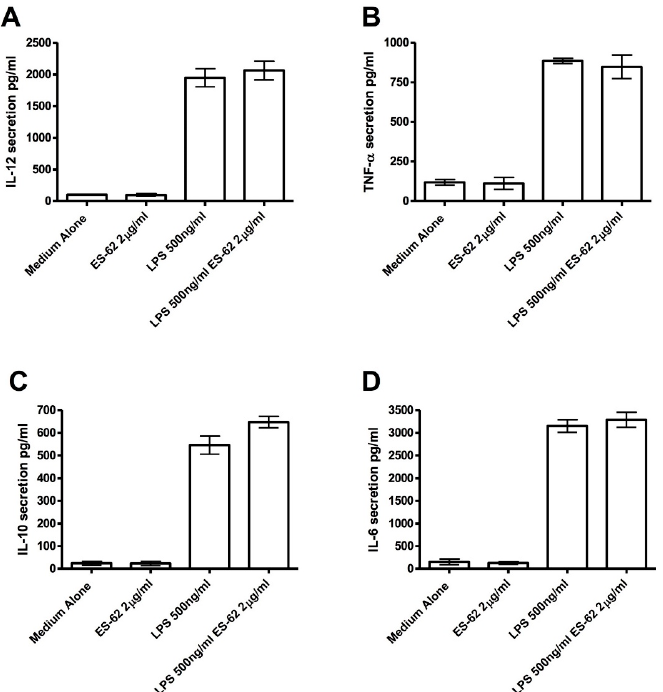
Figure 2. Effects of ES ‐ 62 on in vitro cytokine secretion by dendritic cells (DCs). DCs were prepared from bone marrow as described in the Materials and Methods. On day 10, they were harvested and incubated with medium alone, 500 ng/mL of LPS, 2 μ g of ES ‐ 62 or with both 500 ng/mL of LPS and 2 μ g of ES ‐ 62. At 72 h, supernatants were harvested and assayed for the presence of ( A ) IL ‐ 12p40, ( B ) TNF ‐α , ( C ) IL ‐ 10, and ( D ) IL ‐ 6. Data points correspond to the mean plus SEM of each set of samples.